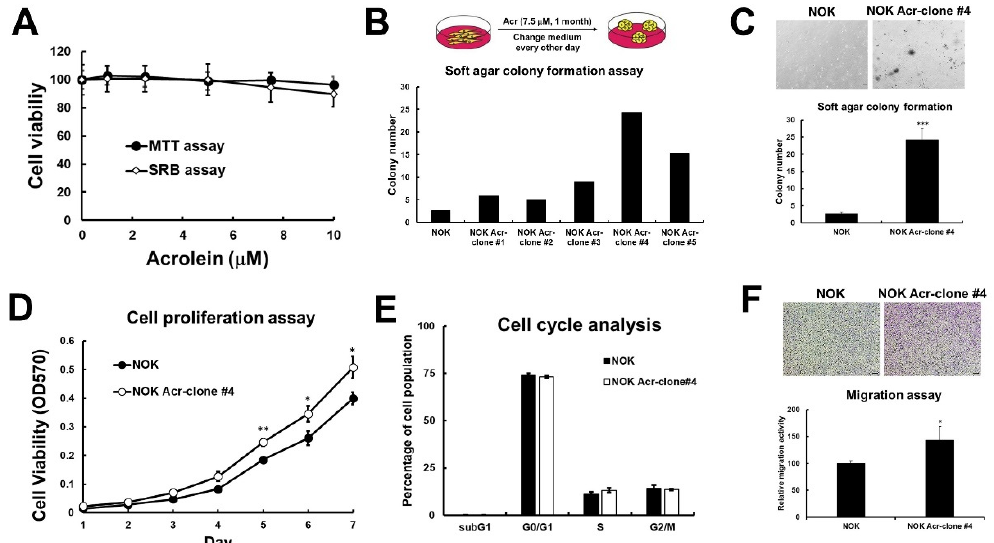
Figure 1. Acrolein induced cell transformation in normal human keratinocytes (NOK). ( A ) Cell viability of NOK under low dose of acrolein (0–10 µ M) treatment for 1–3 days was analyzed using MTT assays and SRB assays. ( B ) NOK cells were treated acrolein (Acr, 7.5 µ M) for one month and named as Acr-clone #1–5. Anchorage independent cell growth of NOK Acr-clone #1–5 was analyzed using soft agar assays. ( C ) Soft agar anchorage-dependent cell growth of NOK Acr-clone #4 was analyzed using soft agar assays. ( D ) Cell proliferation of NOK Acr-clone #4 was analyzed using MTT assays. ( E ) Cell cycle progression of NOK Acr-clone #4 was analyzed using cell cycle analysis with PI staining. ( F ) Cell migration activity of NOK Acr-clone #4 was analyzed using transwell migration analysis. Data were presented as the mean ± s.d. Student’s t -tests were used to determine statistical significance, and two-tailed p -values are shown. *** p < 0.005, ** p < 0.01, * p < 0.05 compared with NOK parental cells.